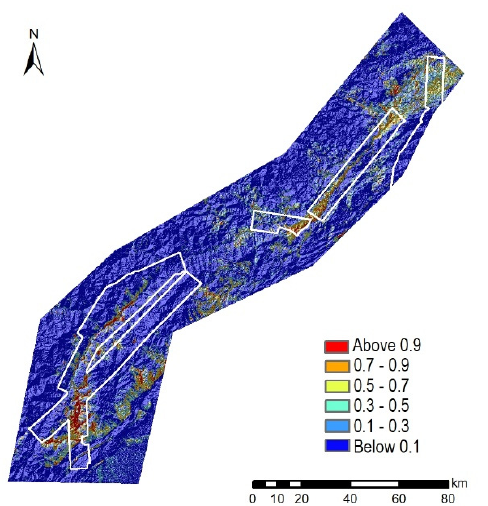
Figure 13. Application U-net model to predict the landslide susceptibility of the whole study area.